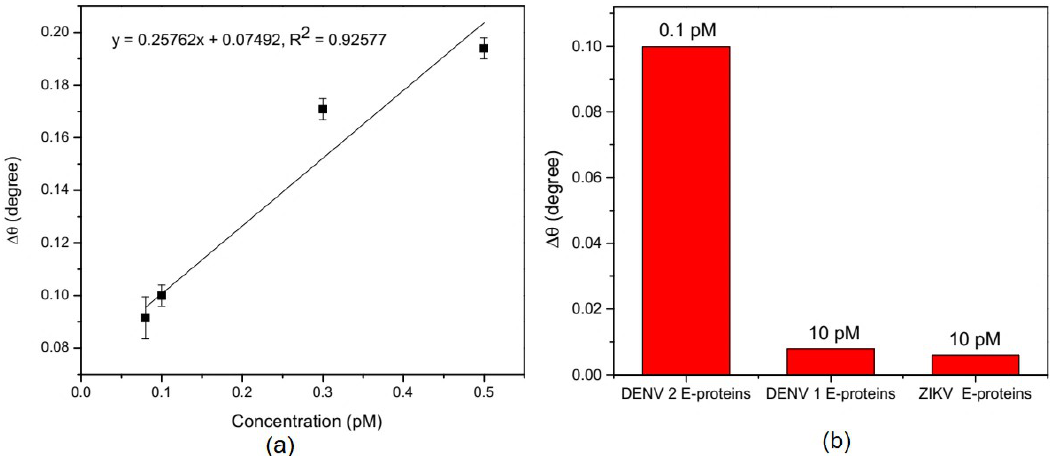
Figure 10. ( a ) Calibration curve or SPR angle shift at different DENV 2 E-Protein concentrations, ( b ) The response of the SPR chip to different antigens (DENV 2 E-Protein, DENV E-protein, and ZIKV E-protein) (adapted with permission from Reference [44], copyright